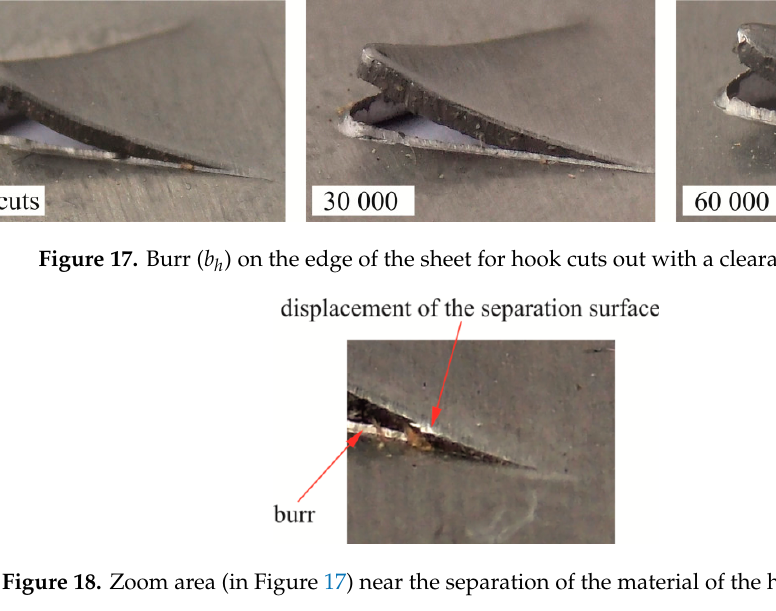
Figure 19. Tool after blanking about 63,000 elements with 5% clearance: ( a ) the principal blanking- punch elements; ( b ) cutting edge wear; ( c ) fatigue wear.